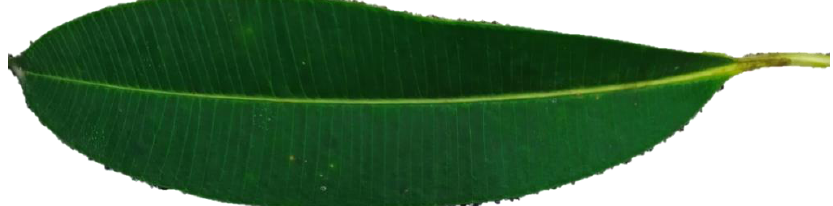
Figure 1. Fresh leaf of A. angustiloba before drying and extraction process.